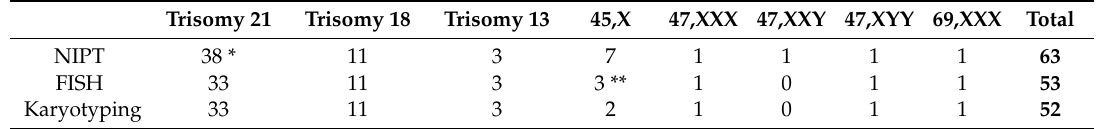
Table 1. The abnormal NIPT cases confirmed by FISH and